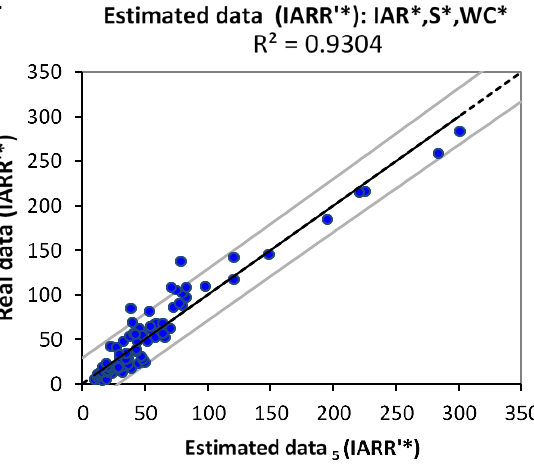
Figure 6. Multiple linear regression curves between real and estimated Ol’Dekop’s rainfall-runoff residual data (IARR’), obtained by ANN 1 transfer functions by using a set of input variables which are ( A ) (IAR*, IARR*/S*); ( B ) (IAR*, IARR*/WC*); ( C ) (IAR*, S*); ( D ) (IAR*, WC*); ( E ) (IAR*, S*, WC*). * input variable linearized by the Ln function, as follow: X i * = Ln X i . Inter-annual rainfall (IAR), watershed area (S), watercourse (WC).